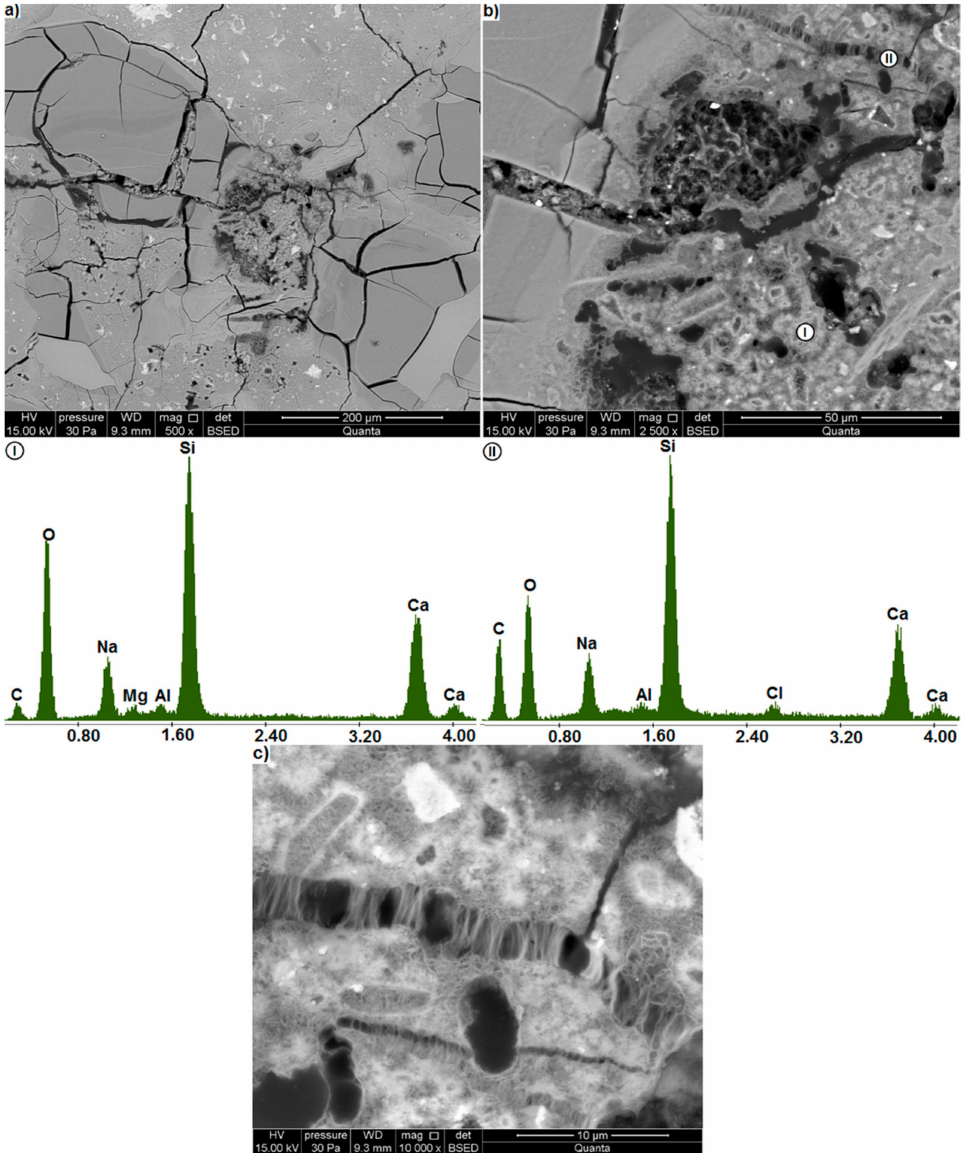
Figure 9. ( a ) extensively cracked region in the microstructure of the mortar containing waste glass ( b ) region of porous gel (BSE); EDS analysis at points I and II, ( c ) cracks in the gel. The author would like to apologize for any inconvenience caused to the readers by these changes. This change will not affect the results of the